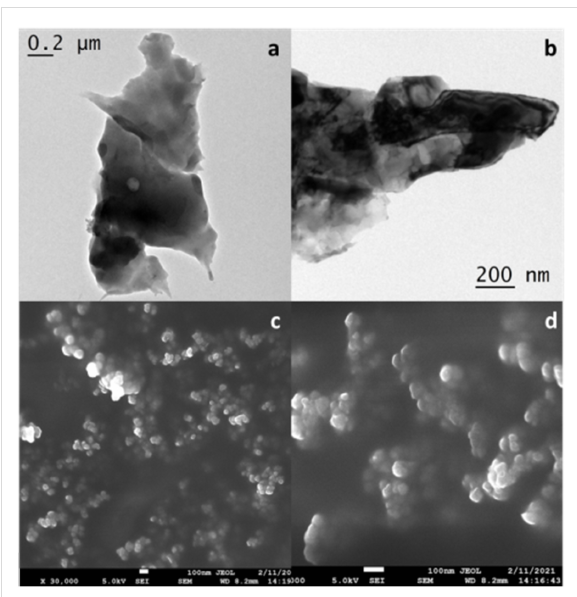
Figure 3: TEM (a and b) and SEM images (c and d) of the Ni–chitosan